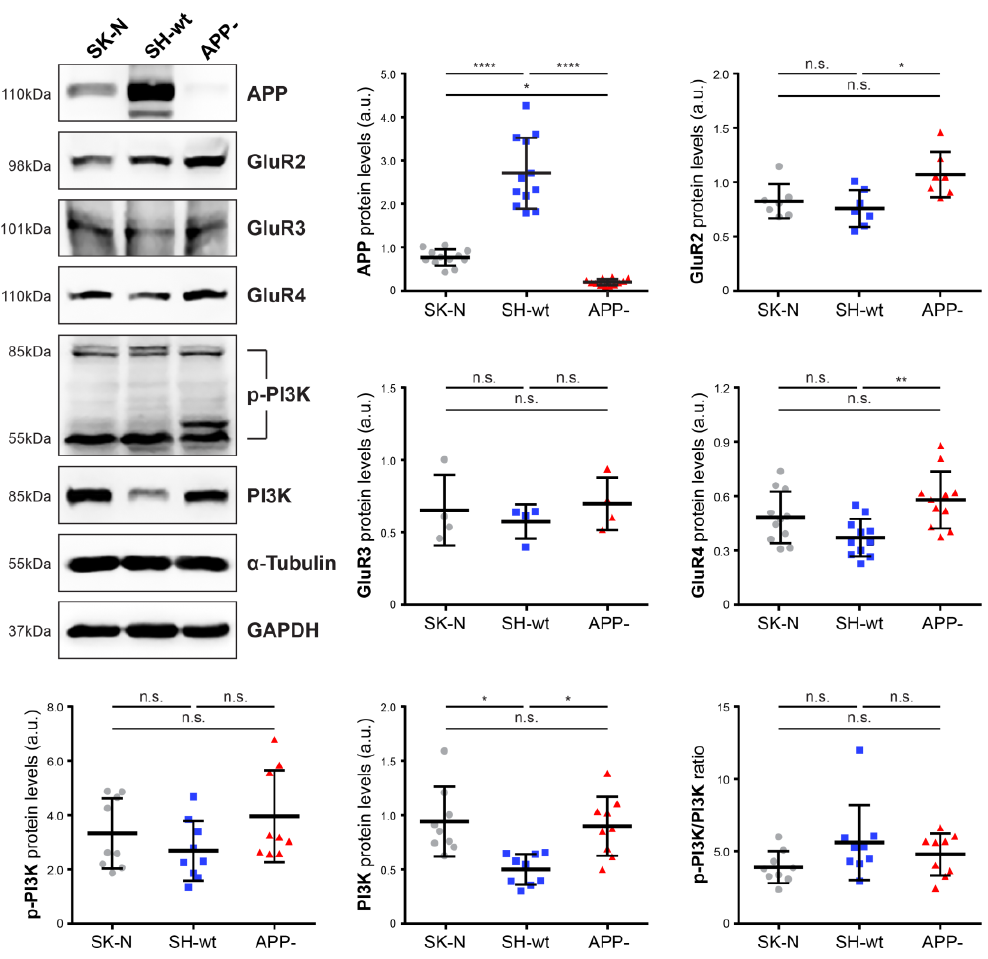
Figure 1. Effects of APP downregulation on plasma membrane proteins. Representative immunoblots and quantification of the levels of APP, GluR2-4, PI3K, and its phosphorylated forms in total protein extracts (50 μg/lane) from SH -SY5Y (SH-wt), SH-SY5Y/APP- (APP-) and SK-N-SH (SK-N)